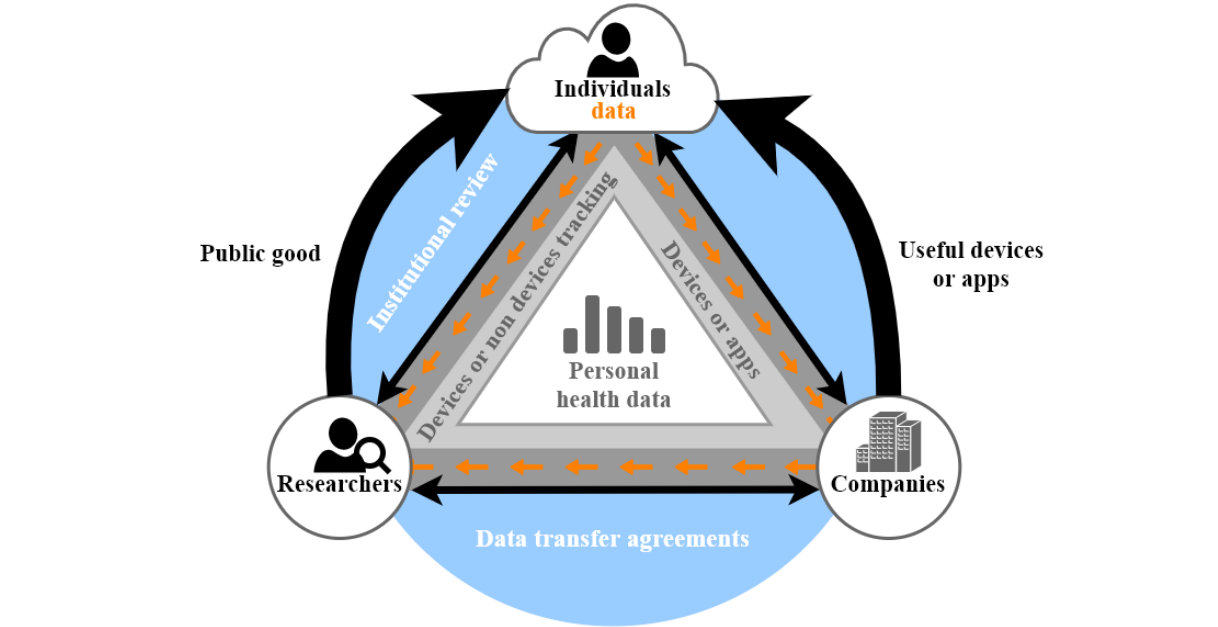
Figure 4. Personal health care data